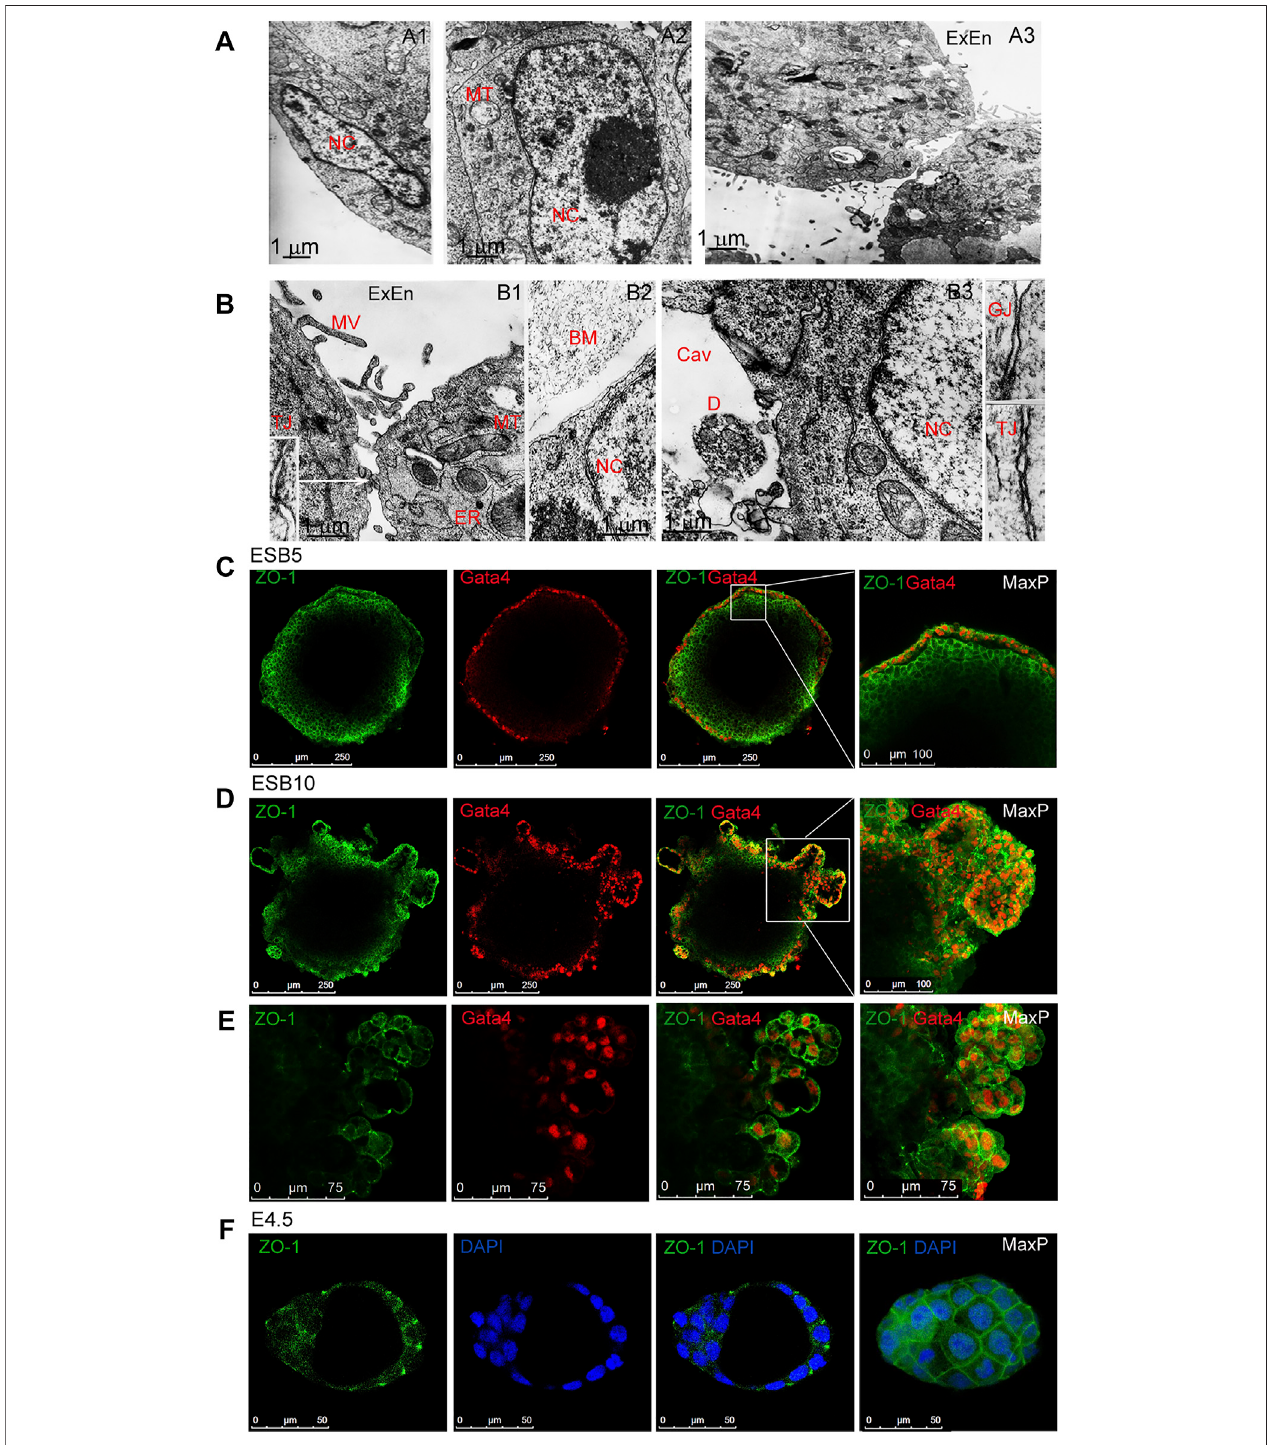
FIGURE 4 | Cellular ultrastructure and contacts in differentiating EBs. (A,B) Electron microscopy images of outer and inner cells of EB1 [(A),A1,A2] and EB5 [(A), A3],[(B),B1 – B3] .Gap(GJ)andtight(TJ)junctionsbetweentheExEnandEpi-lcellsinsidebars(140000xmagni fi cation).Nc,nucleus,MT,mitochondria,MV,microvillus; ER, endoplasmic reticulum; BM,basal membrane; Cav, inner cavity, D, cell debris. (C,D,E) Representative confocal images and maximal projections ofZO-1 and Gata4 double staining in ExEn and Epi-l cells of EB5 (C) and overgrown ExEn structures of EB10 (D,E) . (F) Representative images and maximal projections of ZO-1 and DAPI double staining in the E4.5 mouse